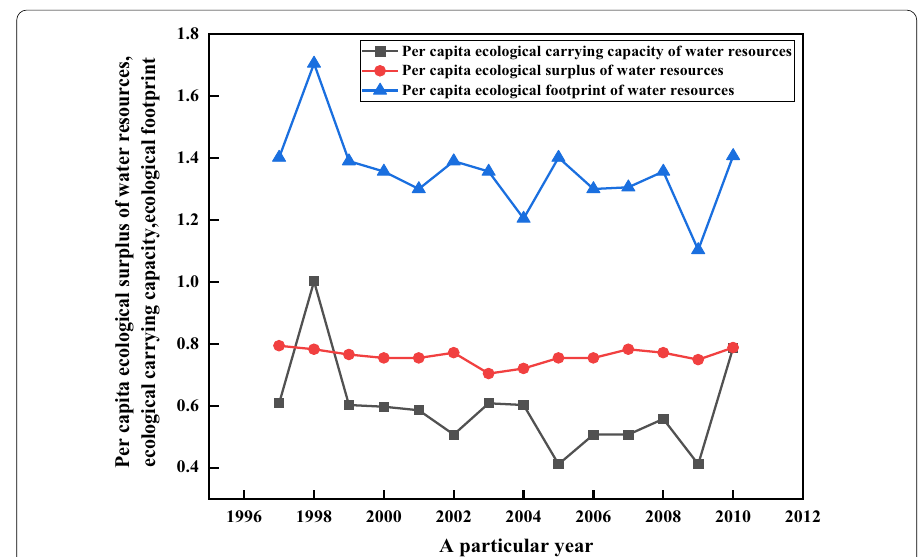
Fig. 6 Ecological footprint, ecological carrying capacity and ecological surplus of per capita water